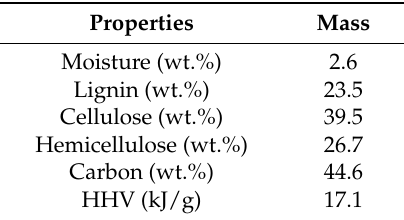
Table 1. The main properties of the